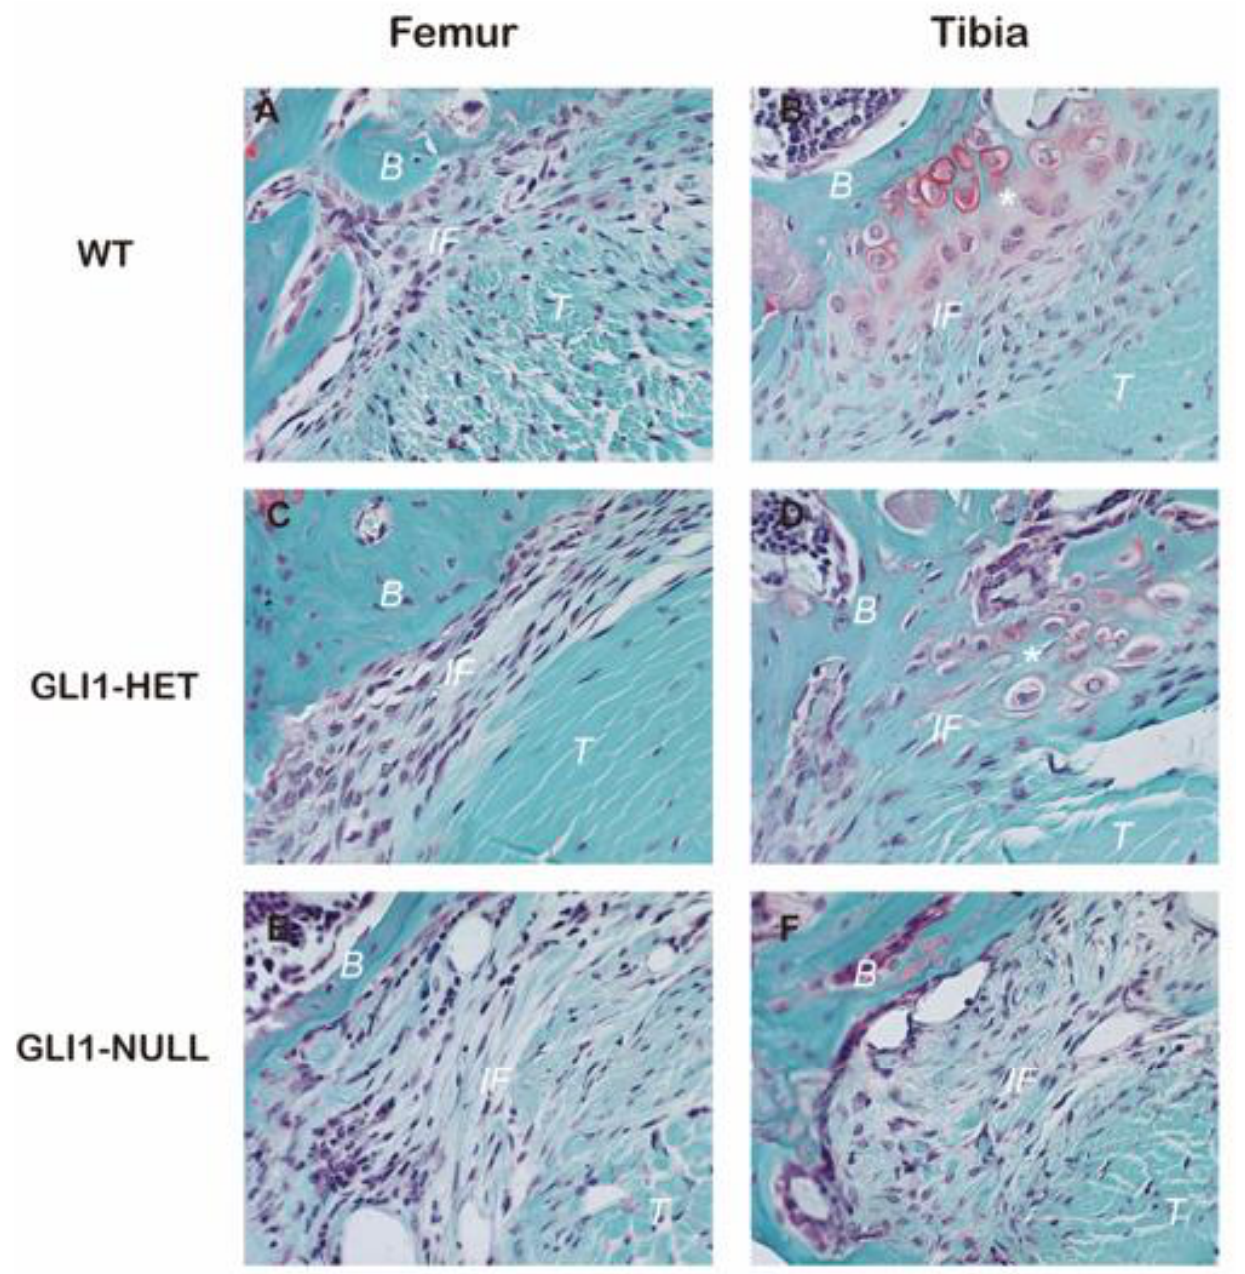
Figure 4. Safranin-O staining of the tendon–bone interface of wild-type ( A , B ), GLI1-HET ( C , D ) and GLI1-NULL ( E , F ) mice at 4 weeks after ACLR (40×). Fibrocartilage-like cells were observed at the tibial tunnel interface in the WT group and Gli1-HET group. (B: Bone tissue, IF: Interface, T: Tendon graft, *: Fibrocartilage-like cell).